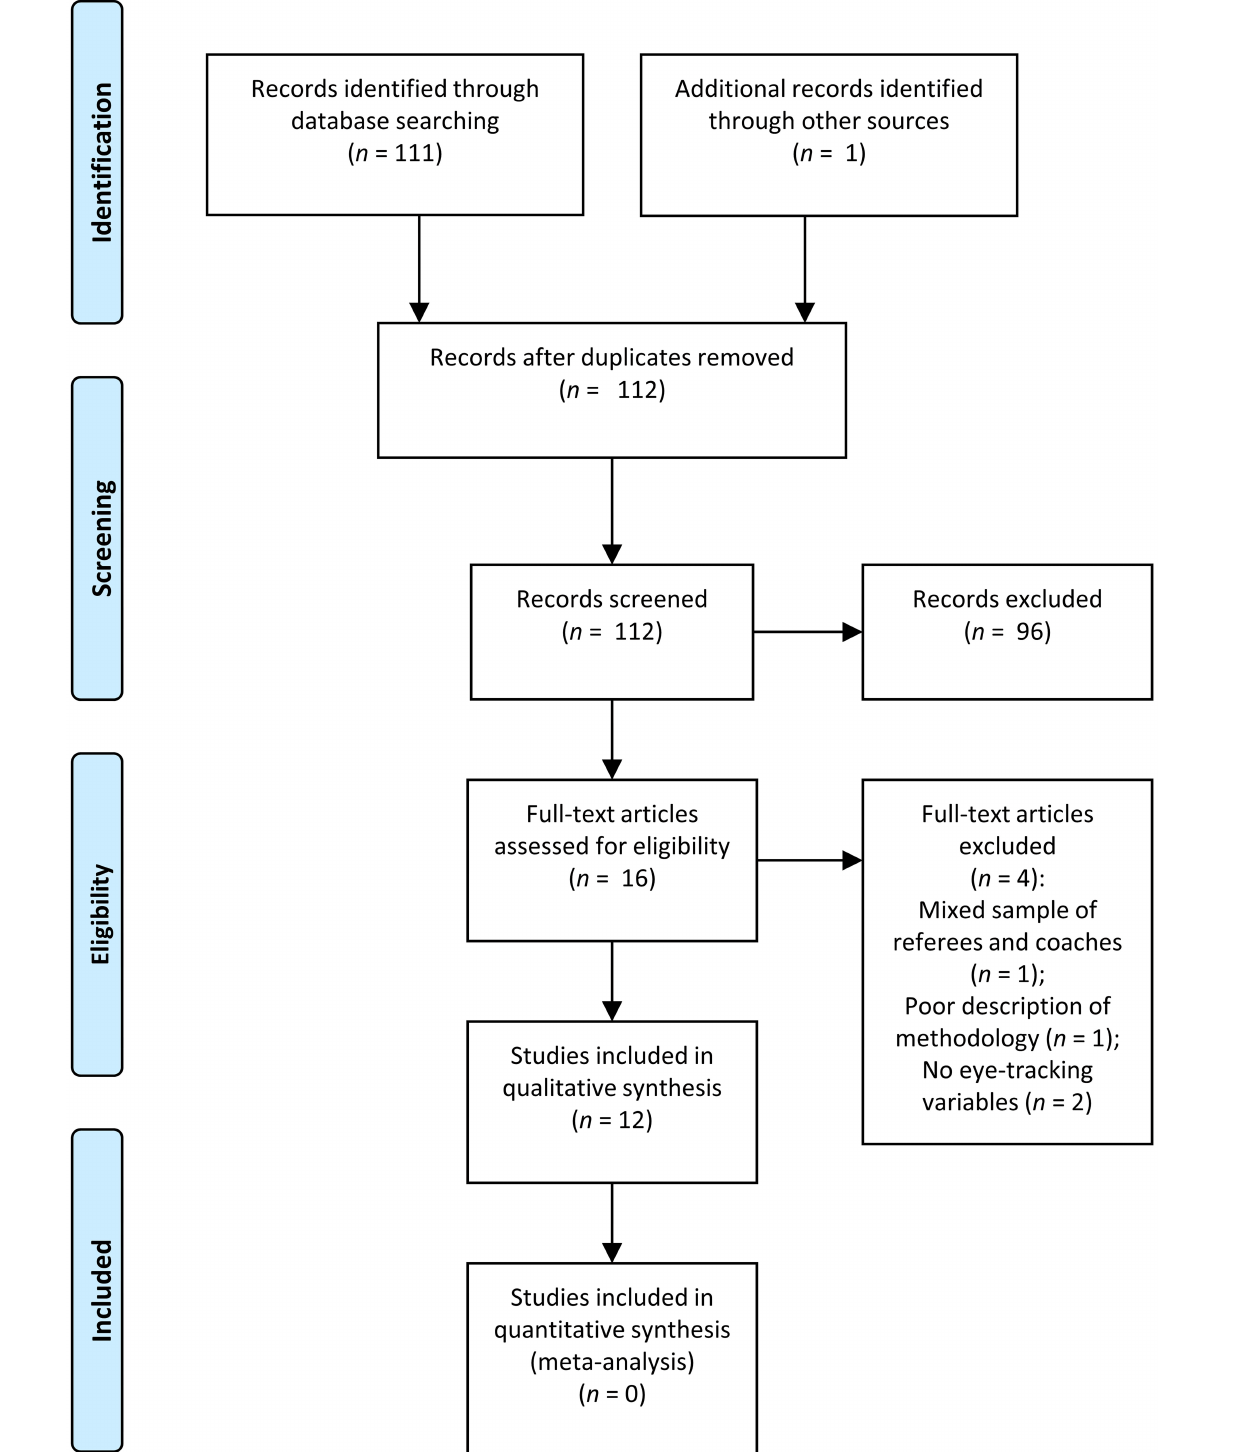
Frontiers in Sports and Active Living |